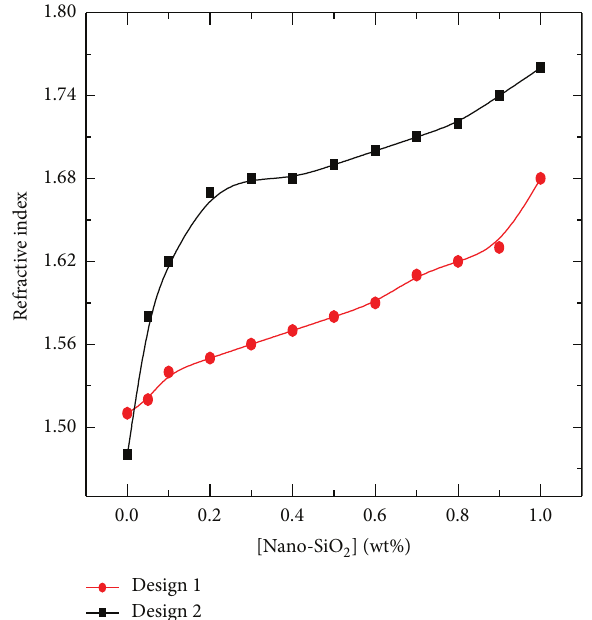
Figure 6: Effect of nanosilica concentration on the refractive index of TLSC